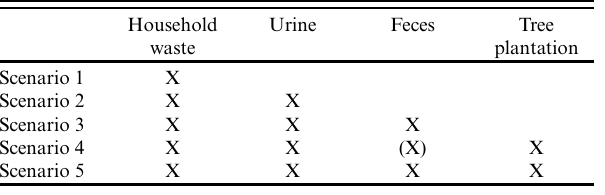
Table 3 . Scenarios considered in this study: The first scenario recycles all household wastes without human excreta. Scenario II additionally includes urine, and scenario III, both urine and feces.